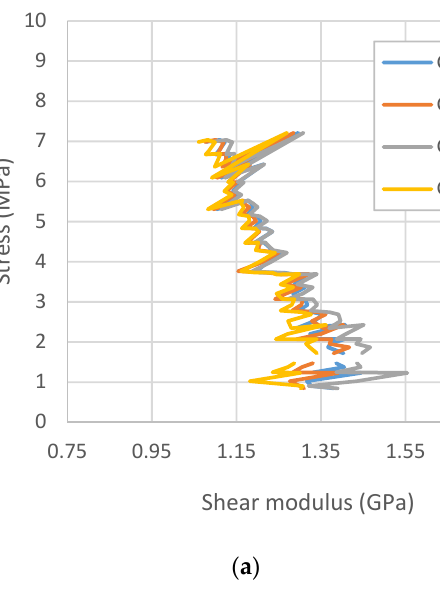
Figure 8. Relationship between the measured values of the shear strain angles and the value of the stress in the plate. The analytical angle was designated based on the value presented in Figure 9.